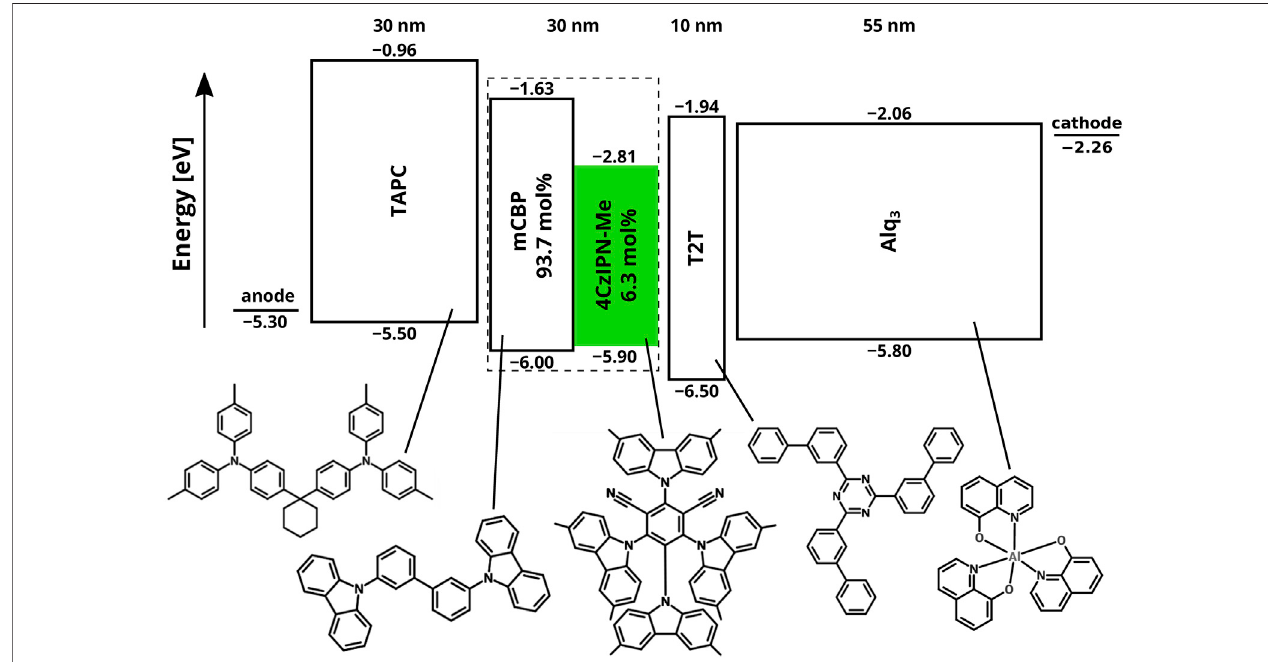
FIGURE 1 | Layer structure and energy levels (with respect to the vacuum level, in units eV) of the TADF device studied in this paper. The HOMO energies, E HOMO , weredeterminedbyphotoelectronyieldspectroscopy(Nakanotanietal.,2014;Furukawaetal.,2015).TheLUMOenergies, E LUMO ,areobtainedusing E LUMO (cid:2) E HOMO + E S + E S,b , with E S the singlet energy (see Table 1 ) and E S,b the singlet binding energy. The importance of including the proper value for the exciton binding energy in the value of the LUMO that is used in KMC simulations was demonstrated in Coehoorn et al. (2015) and Ligthart et al. (2021). Based on inverse photoelefctron spectroscopy, the values of E S,b for 4CzIPN-Me and Alq 3 were taken as 0.61 and 1.21 eV, respectively. 1 The exciton binding energy of 4CzIPN-Me is assumed to be equaltothatof4CzIPN,studiedinYoshidaandYoshizaki(2015).Fortheothermaterialswetake E S,b (cid:2) 1.0 eV(Knupfer,2003).Theinjectionbarriersattheanode,witha hole injection layer [see Furukawa et al. (2015)], and at the LiF-Al cathode layer are taken equal to 0.2